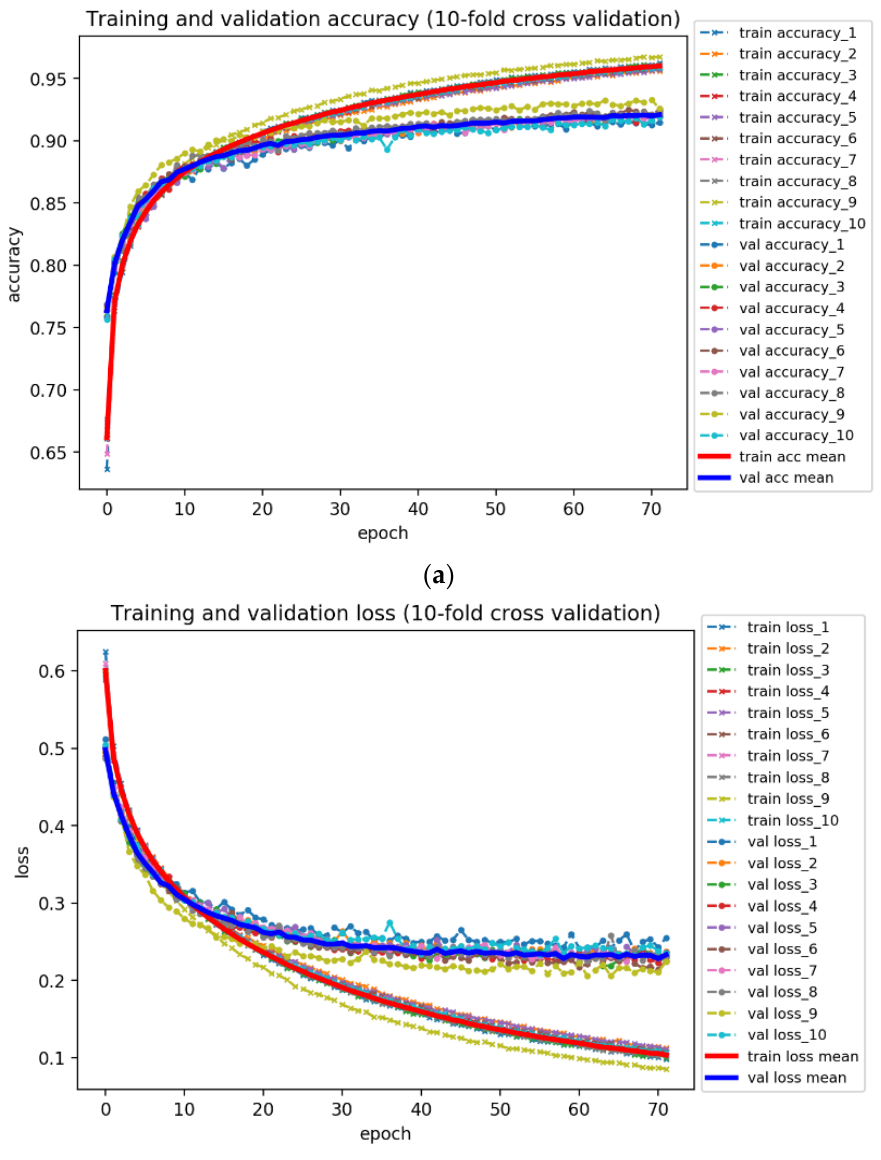
Figure 7. Training and Validation Learning curves (10- fold cross validation). “ -x- ” lines in different colors denote the training accuracy and loss, while “ -o- ” lines in different colors represent the validation accuracy and loss in ( a , b ), respectively. The bold lines in red and blue indicate the model’s average loss and accuracy of training and validation in ( a , b ), respectively. Moreover, since stopping the training of the neural network early before it has overfitted the training dataset can reduce overfitting and improve the generalization of the DTI model, Early Stopping approach is additionally employed to automatically stop the learning process at the epoch of 70.